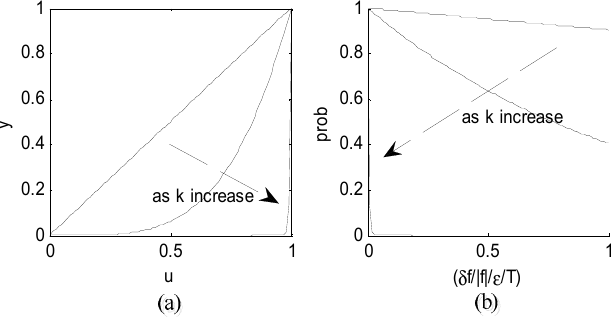
Figure 1. ( a ) The function curves of the random solution generator y = µ k , k = 1, 4, 200 and ( b ) the function curves of the acceptance criterion prob = e